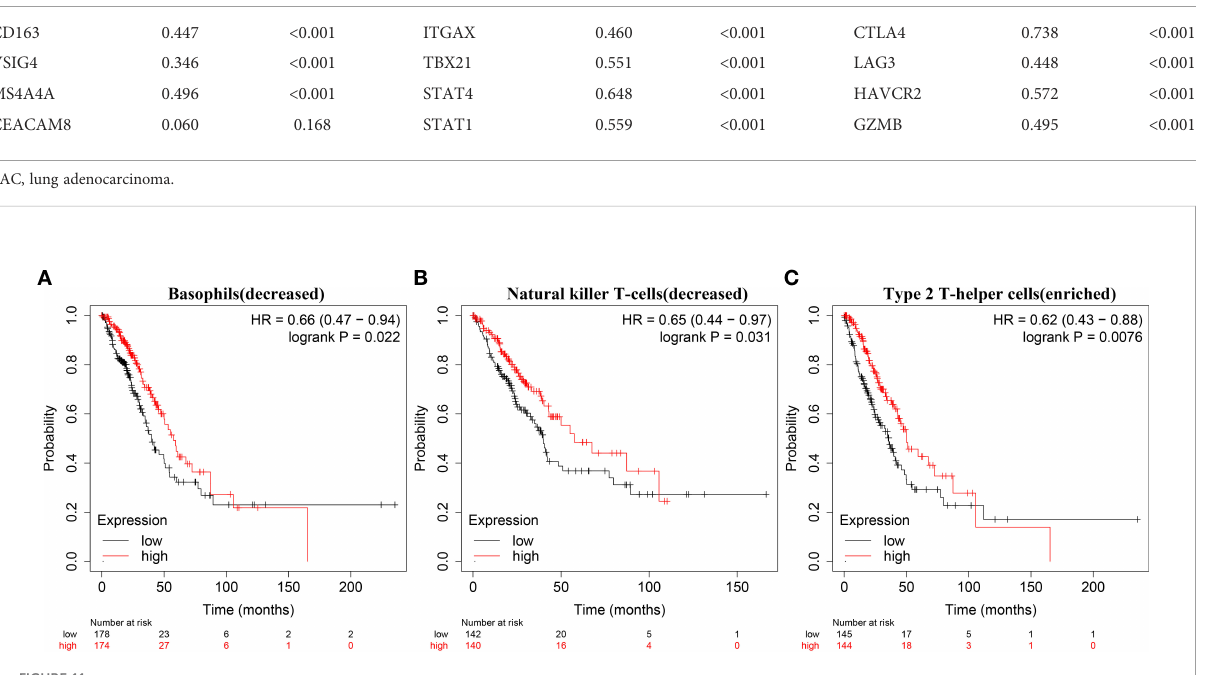
FIGURE 11 Decreased expression of TRAT1 was signi fi cantly associated with prognosis-related immune cells in patients with LAC. (A) Basophils (decreased); (B) Natural killer T-cells (decreased); (C) Type 2 T-helper cells (enriched). LAC, lung